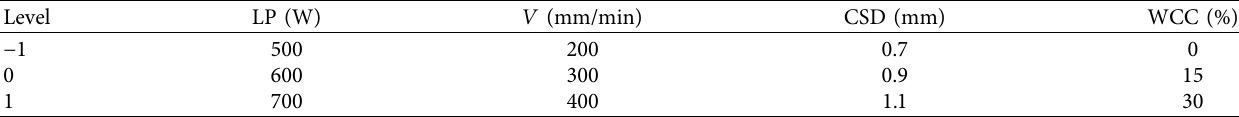
Table 3: Laser process parameters and the level design.